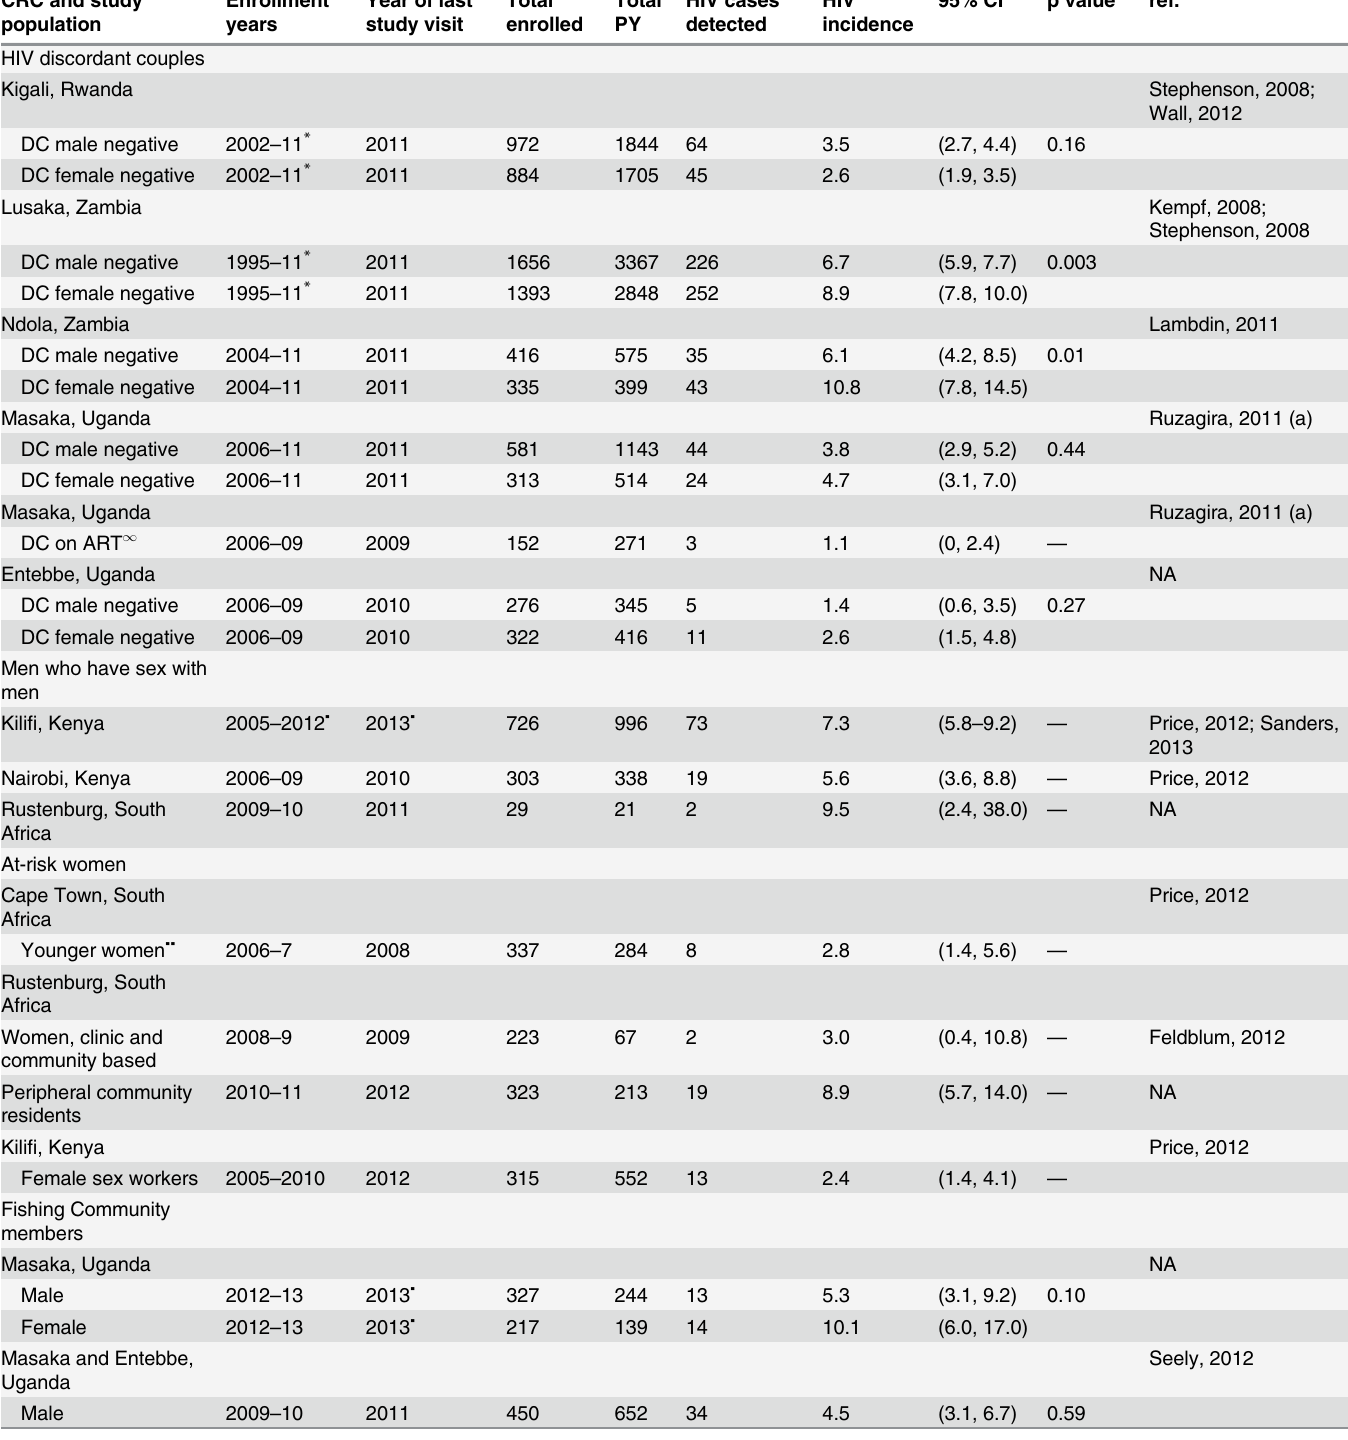
Table 2. Enrollment and HIV incidence among at-risk volunteers enrolled for HIV prevention preparatory studies strati fi ed by CRC and, where appropriate, sex. CRC and study